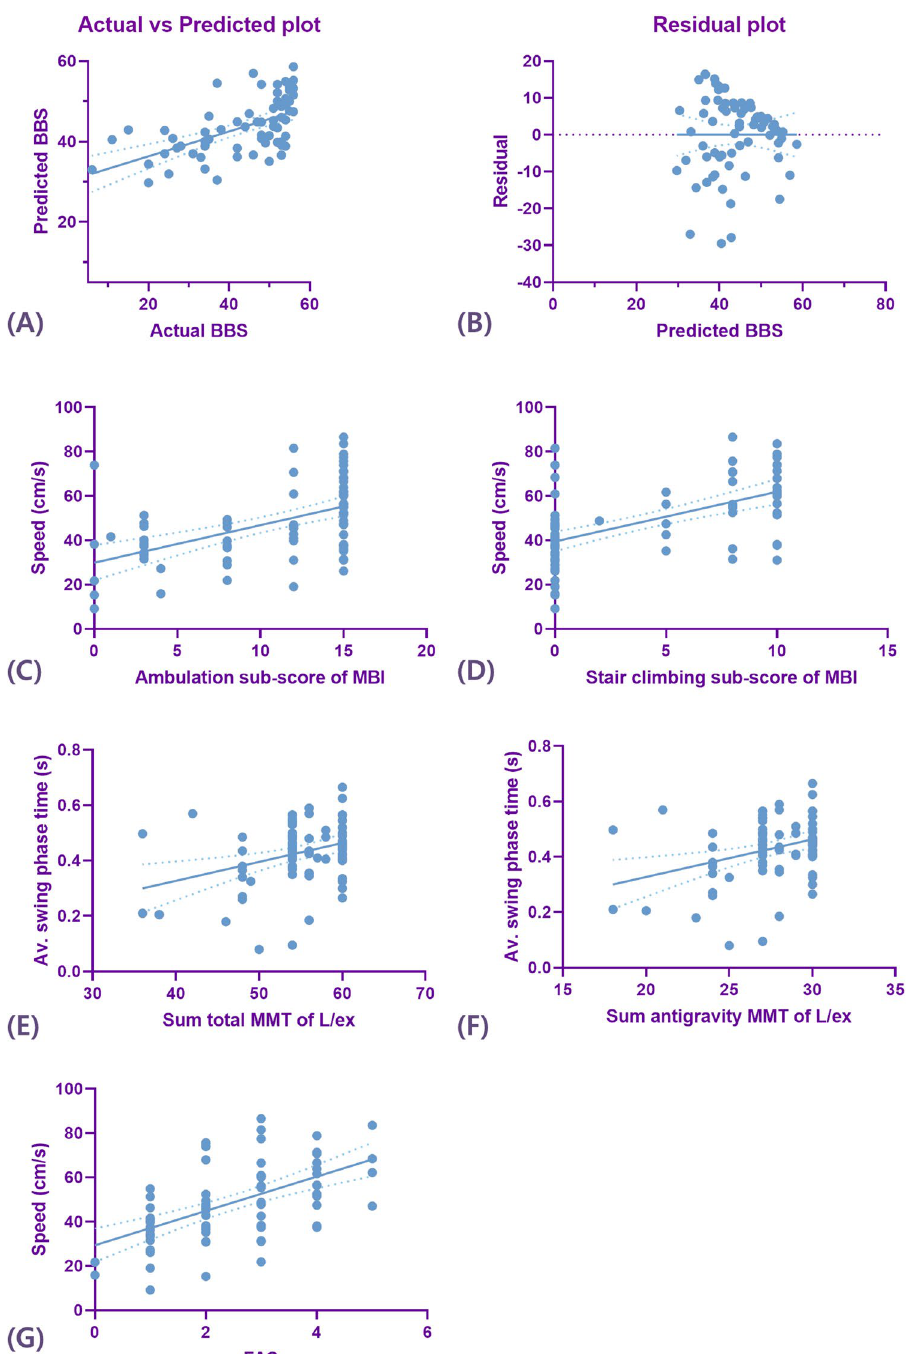
Figure 1. The correlations between the Berg balance scale (BBS) score ( A ) and temporo-spatial parameters of gait ( B ); between the ambulation sub-score of the modified Barthel index (MBI) and temporo-spatial parameters of gait ( C ); between the stair-climbing sub-score of the MBI and temporo-spatial parameters of gait ( D ); between the total summation of the manual muscle test (MMT) score of the lower extremities and temporo-spatial parameters of gait ( E ); (between the summation of the MMT score of the anti-gravity muscles (hip extensor, knee extensor, and ankle plantar flexor muscles) of the lower extremities and temporo-spatial parameters of gait ( F ); and between the functional ambulation category (FAC) and temporo-spatial parameters of gait ( G